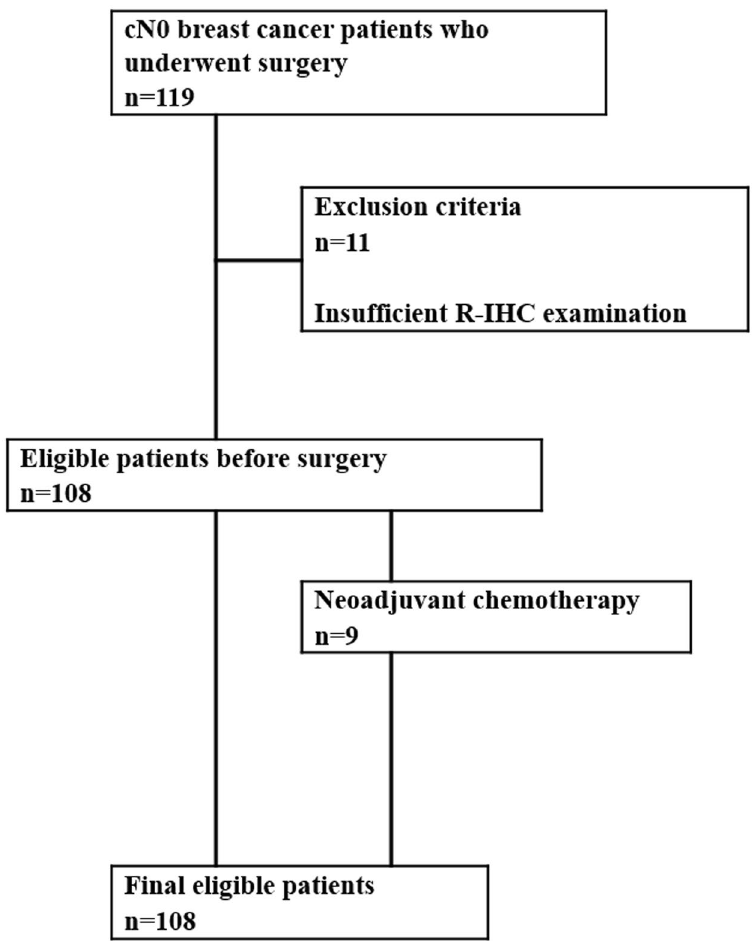
Figure 2. Diagram for patients